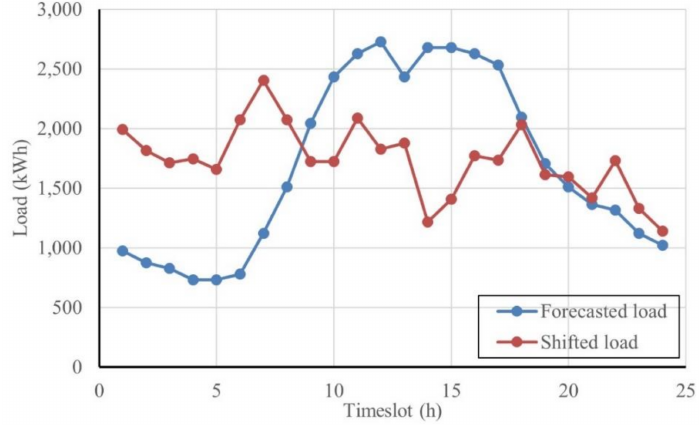
Figure 16. Hourly industrial load before and after DSM using the distributed algorithm RTP-SBY.